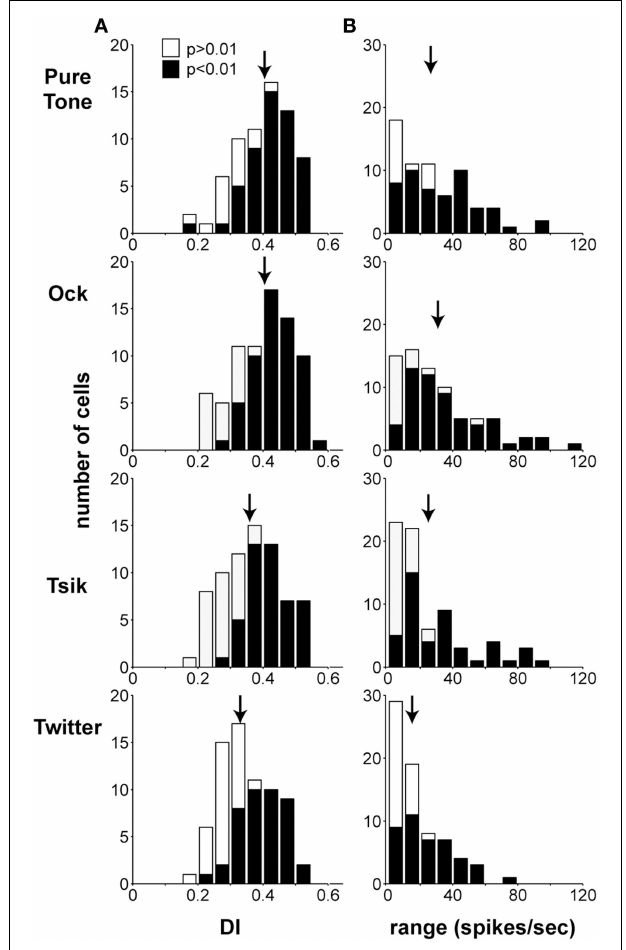
FIGURE 5 | Discrimination index (DI) and modulation range. Column (A) shows the distribution of DI ABL opt for all stimulus types. Column (B) shows the distribution of modulation range with respect to changes in ILD at the ABL opt . Shading of bars in both columns indicates whether or not these cells were significantly modulated in response to different ILDs. Arrows indicate the means of the